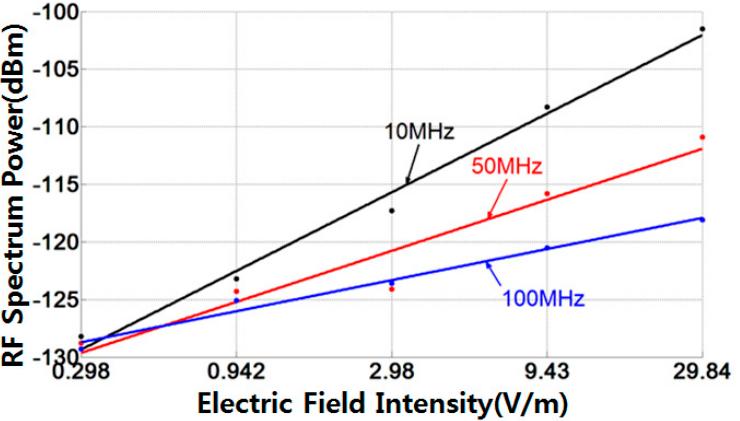
Figure 9. The photo-detected signal power versus the electric-field strength in the TEM cell at different frequencies.